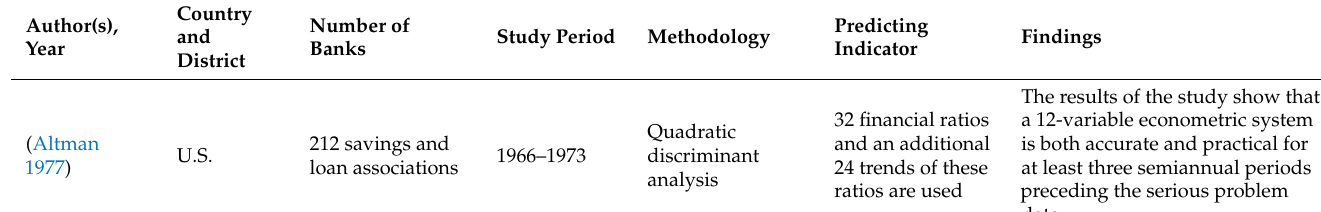
Table 1. The literature